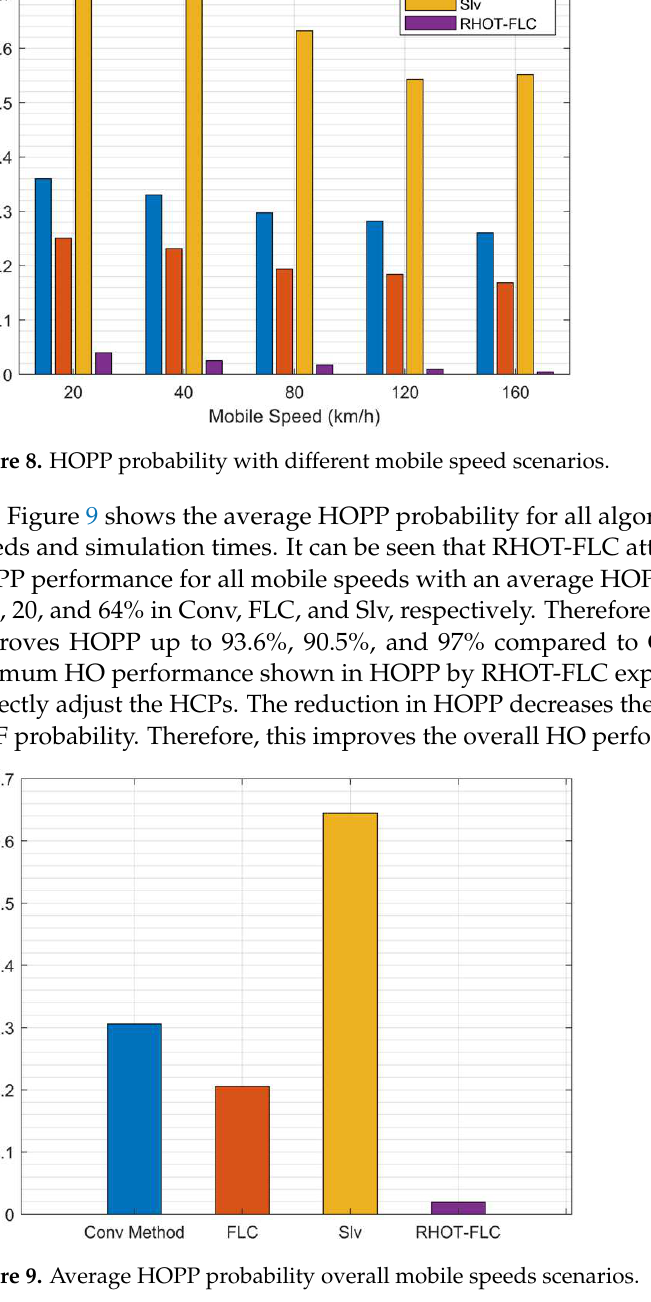
Figure 9. Average HOPP probability overall mobile speeds scenarios.